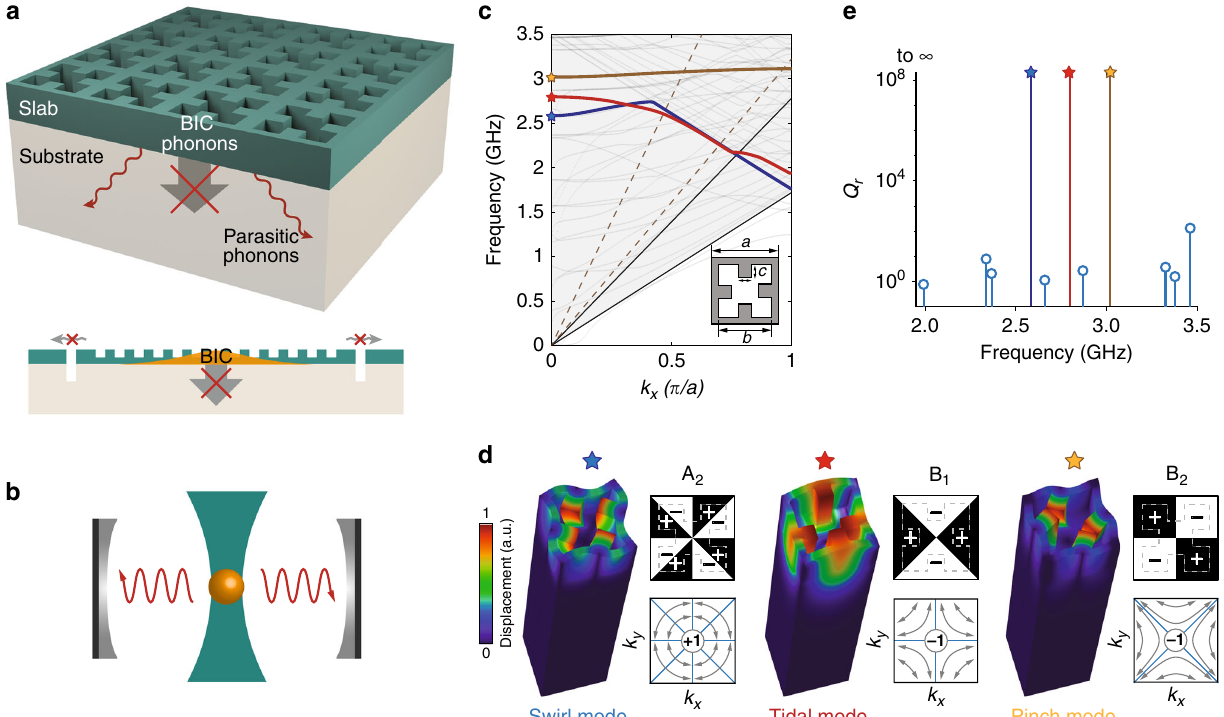
Fig. 1 Phonon trapping via mechanical BICs. a Schematic diagram of a slab-on-substrate PnC which traps selected phonons via mechanical BICs while facilitates dissipation of parasitic phonons via the substrate. b The mechanical BIC architecture resembles levitated particles. c Calculated mechanical bandstructure of an AlN-on-oxide PnC with parameters given in the text. The solid (dashed) lines correspond to the sound lines of transverse and longitudinal waves of SiO 2 (AlN), respectively. Three mechanical BICs at the Γ point and the associated mechanical bands with the consistent symmetry are highlighted. d Simulated total displacement of the three BIC modes (swirl, tidal, and pinch) and their group representation under C 4v symmetry. Also shown is the far- fi eld transverse polarization of Bloch modes of the same band in the vicinity of Γ point, identifying the topological charge of mechanical BICs. Blue lines are the nodal lines of far- fi eld longitudinal polarization. a.u. arbitrary units. e Simulated radiative quality factor of mechanical modes at the Γ point.